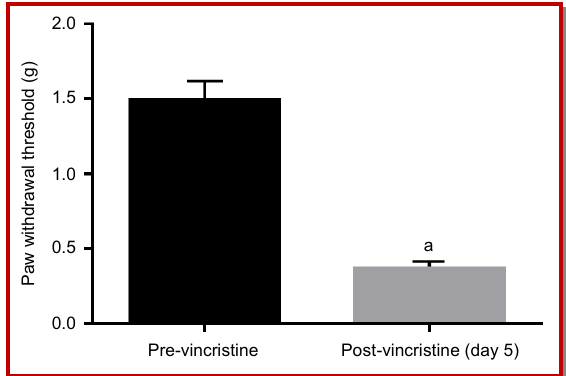
Figure 1: Paw withdrawal thresholds before and after 5 days of daily 0.5 mg/kg vincristine treatment in mice (n = 8 per group). a p<0.001 as compared to pre-vincristine measure-